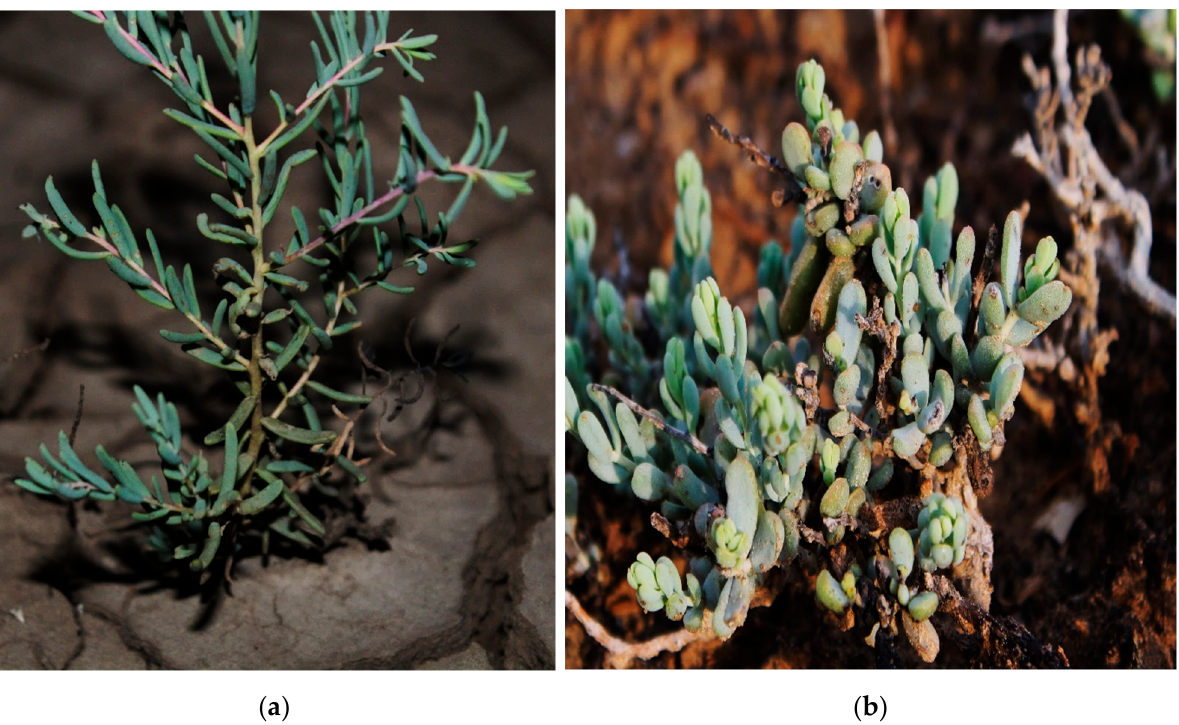
Figure 1. Appearance of the plants in their native environment, ( a ) = Suaeda nudiflora , ( b ) = Suaeda fruticosa.